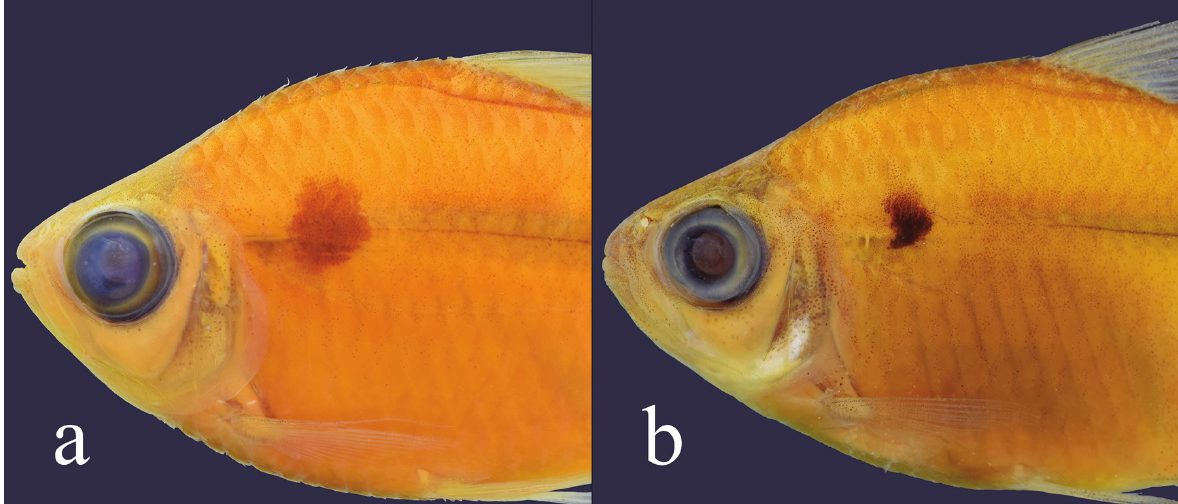
Figure 3. Humeral spot: a ) Moenkhausia britskii , 50.5 mm SL, paratype, MZUSP 17537; b ) Moenkhausia grandisquamis , 48.2 mm SL, MZUSP